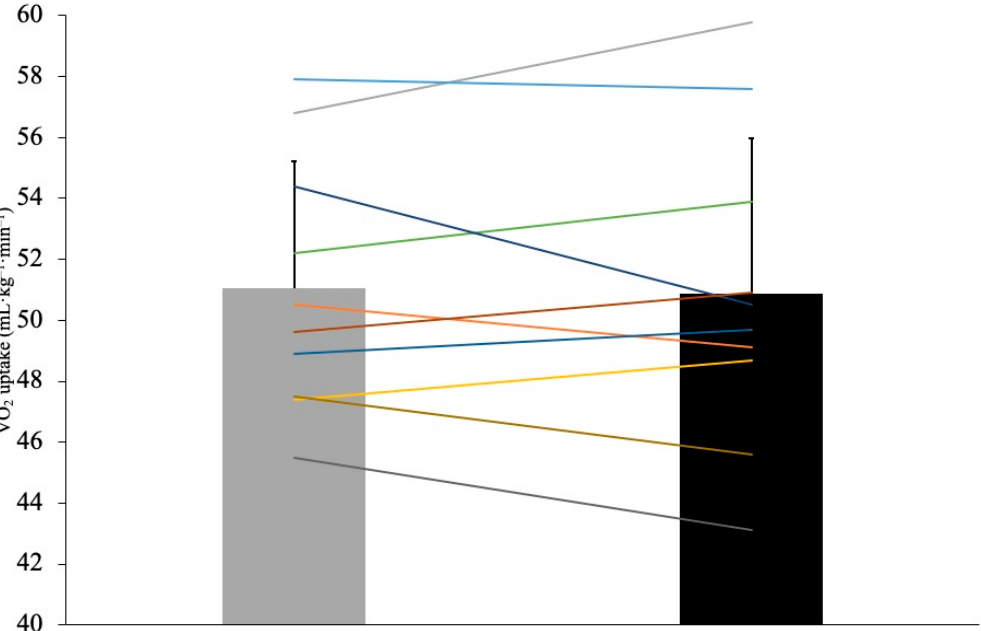
Figure 3. Mean and individual running economy values (mL kg − 1 min − 1 ) of the 10 athletes running in traditional training shoes (grey column) and in grounding shoes (black column).